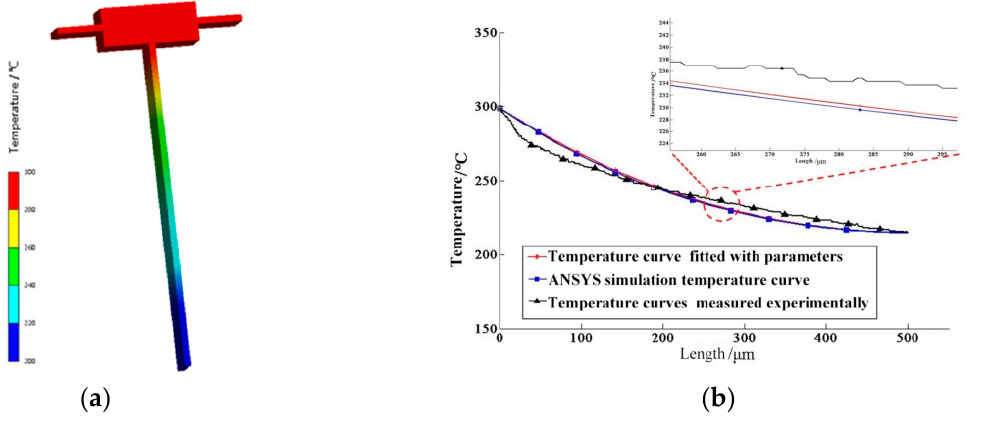
Figure 5. Simulation model and comparison: ( a ) Finite element simulation model; ( b ) comparison of the temperature curves.